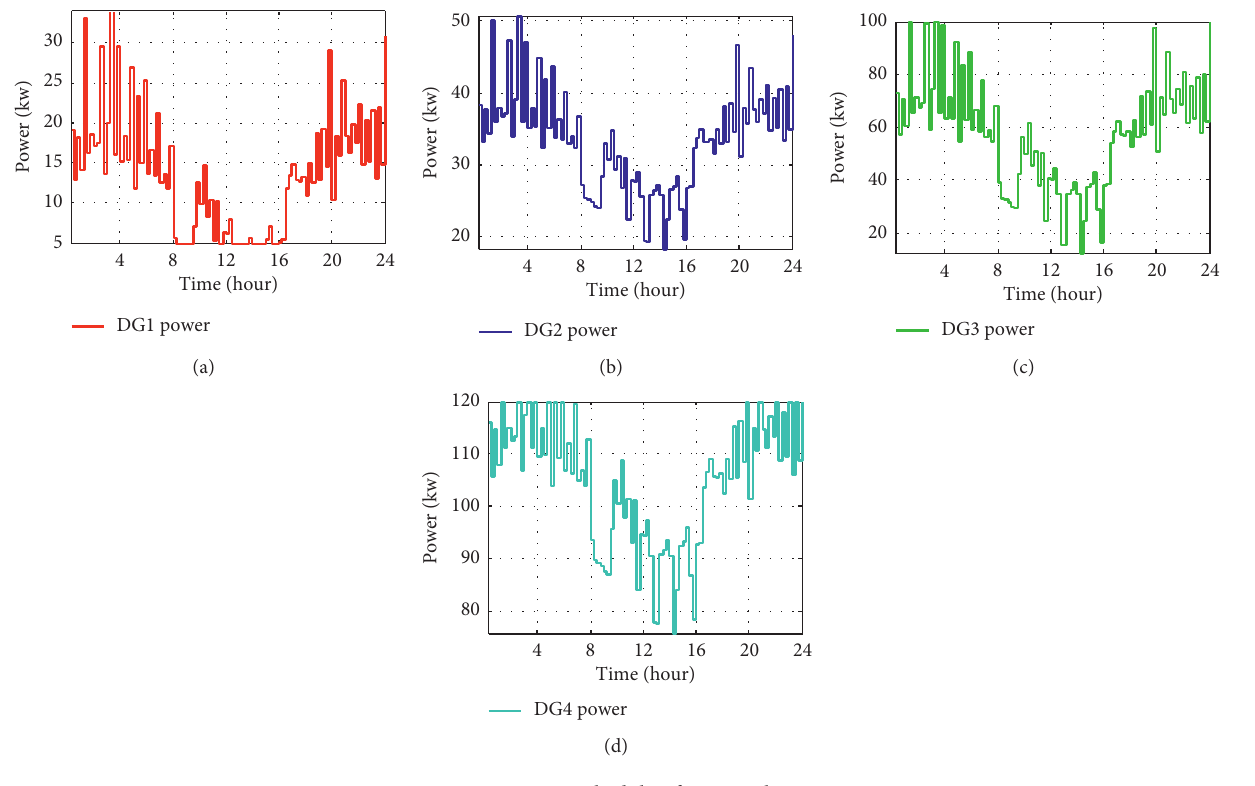
Figure 6: Operation schedule of DGs without ESS.